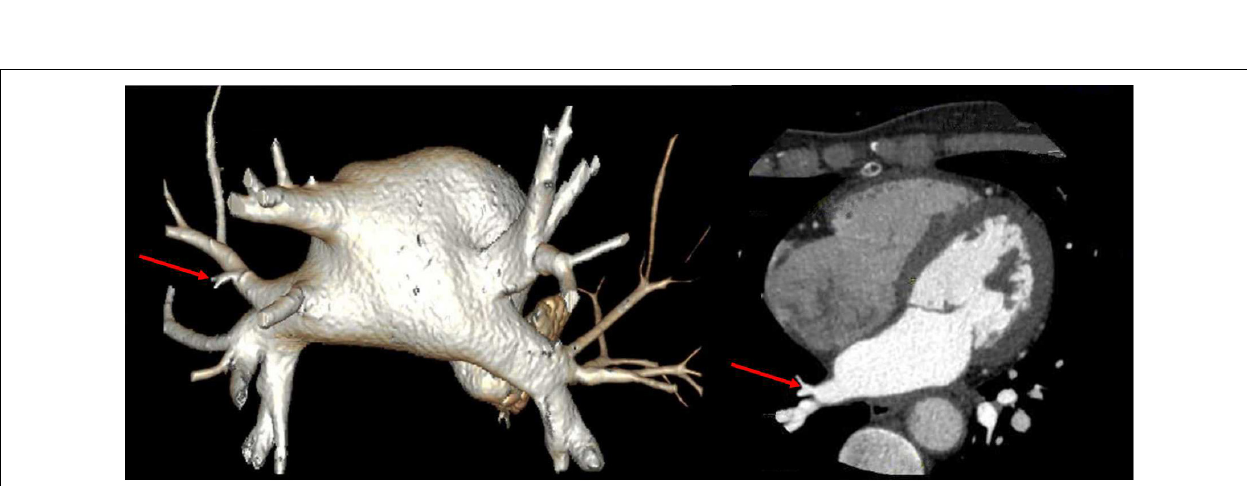
Frontiers in Aging Neuroscience |